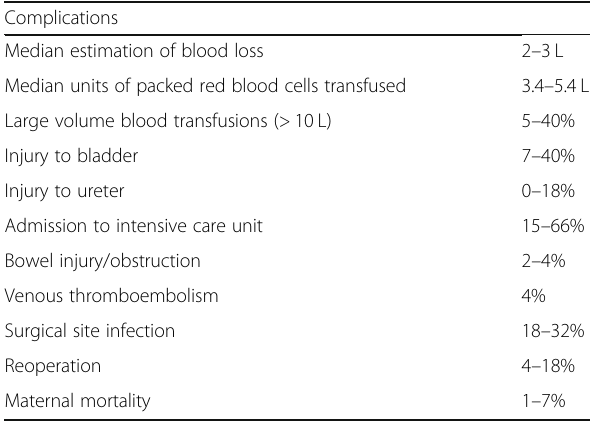
Group A Group B 23 patients 23